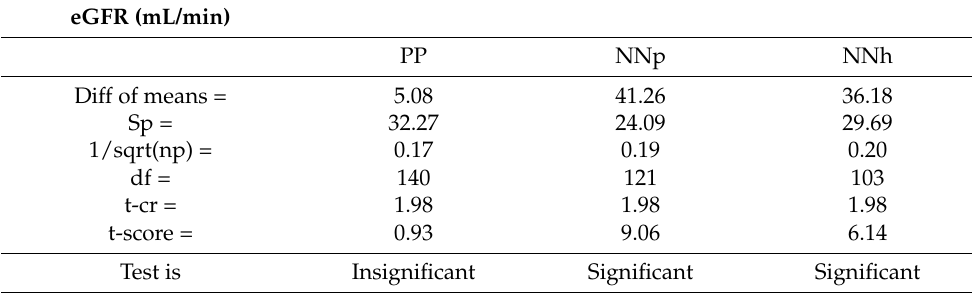
Table 4. The Student’s t -test for differences of the eGFR mean values in PP vs. NNp, PP vs. NNh, and NNp vs. NNh groups. The difference of the mean levels of eGFR in PP, NNp, and NNh groups is statistically insignificant, but the difference of the mean values of eGFR in the NNh compared to both the PP and NNp groups was statistically